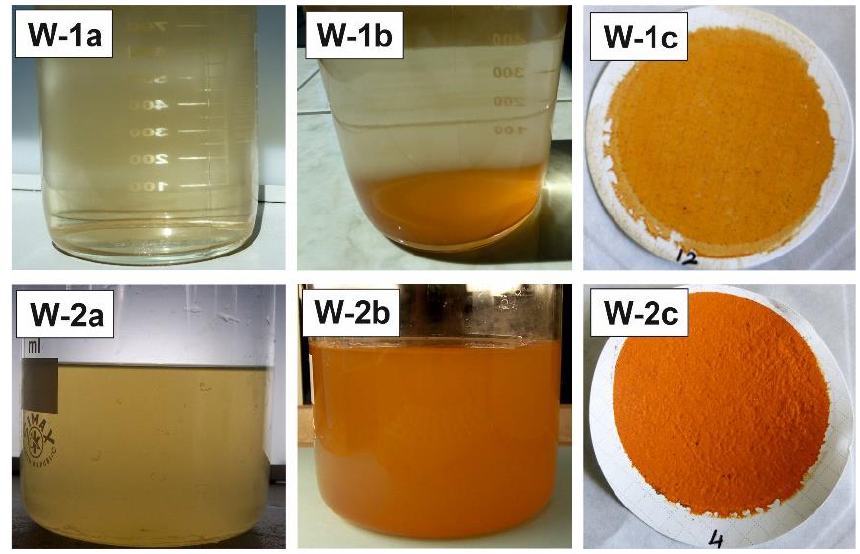
Figure 3. Effect of water aeration (water samples W-1 and W-2: a — raw water without air contact, b — after aeration, c — filter cake).